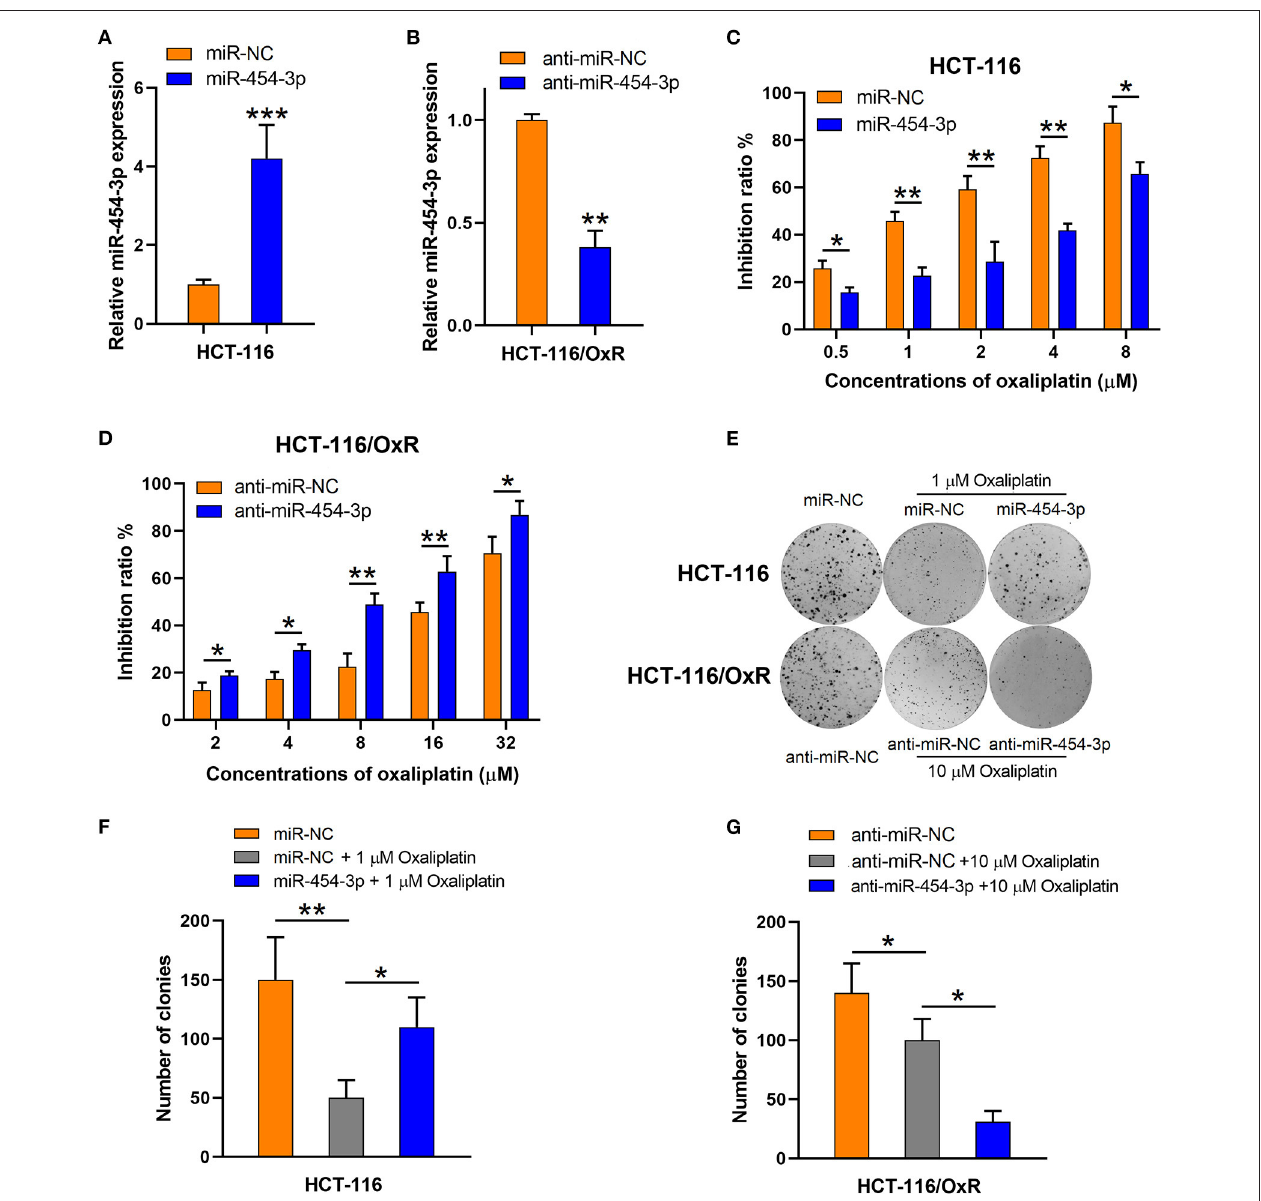
FIGURE 2 | Altering miR-454-3p expression modulates cell sensitivity to oxaliplatin in vitro . (A,B) Quantitative RT-PCR analysis on relative miR-454-3p expression after miR-454-3p was overexpressed in HCT-116 cells (A) or knockdown in HCT-116/OxR cells (B) . (C,D) Inhibitory effects of oxaliplatin on cell viability determined by MTT assay. (C) HCT-116 cells transfected with miR-NC or miR-454-3p, and (D) HCT-116/OxR transfected with anti–miR-454-3p or anti–miR-NC. (E–G) Inhibitory effects of oxaliplatin on colony formation. (E,F) HCT-116 cells transfected with miR-NC or miR-454-3p, and (E,G) HCT-116/OxR transfected with anti–miR-454-3p or anti–miR-NC. Results were presented as mean ± SD from three independent experiments. * P < 0.05, ** P < 0.01, *** P <